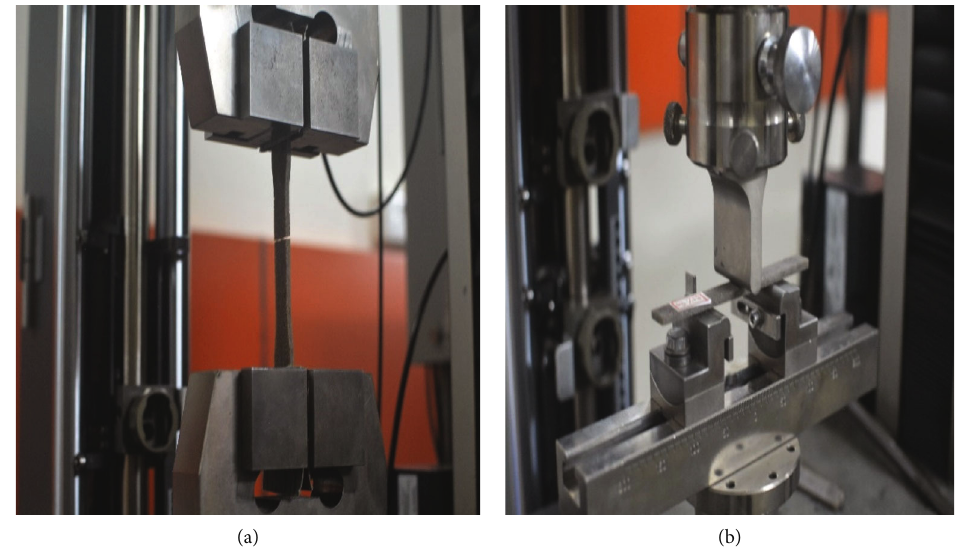
Figure 4: (a) Specimen loaded in tensile test. (b) Specimen loaded in three-point bending fl exural